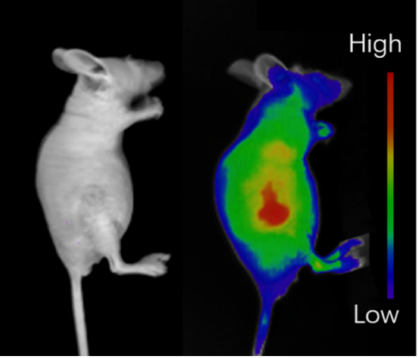
Figure 7. Fluorescence imaging of tumor sites in nude mice bearing